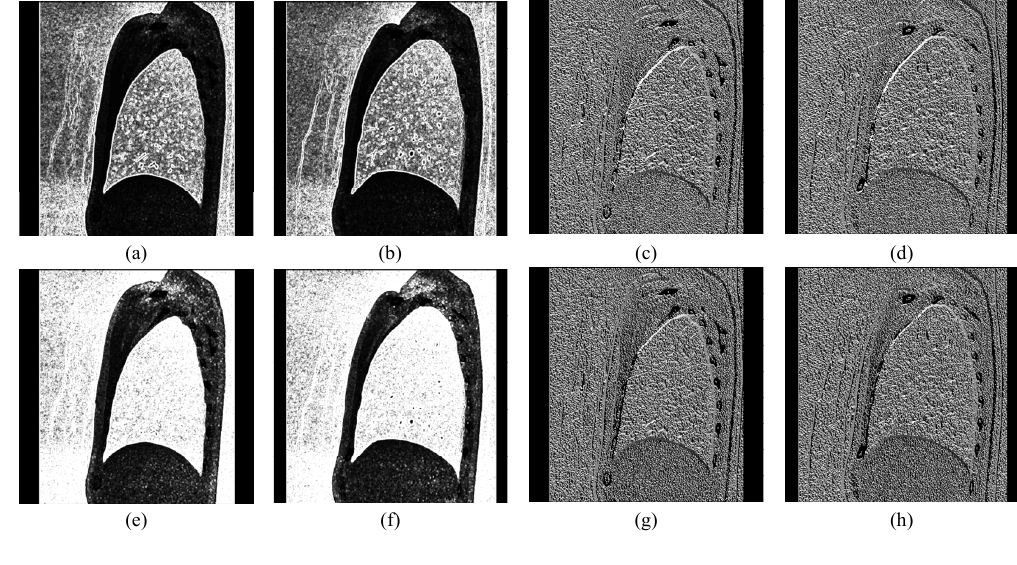
Figure 7. Examples of edge enhancement after (a,b) the amplitude of Robinson filter ( RFA ); (c,d) the orientation of Robinson filter ( RFO ); (e,f) the amplitude of Kirsch filter ( KFA ); (g,h) the orientation of Kirsch filter ( KFO